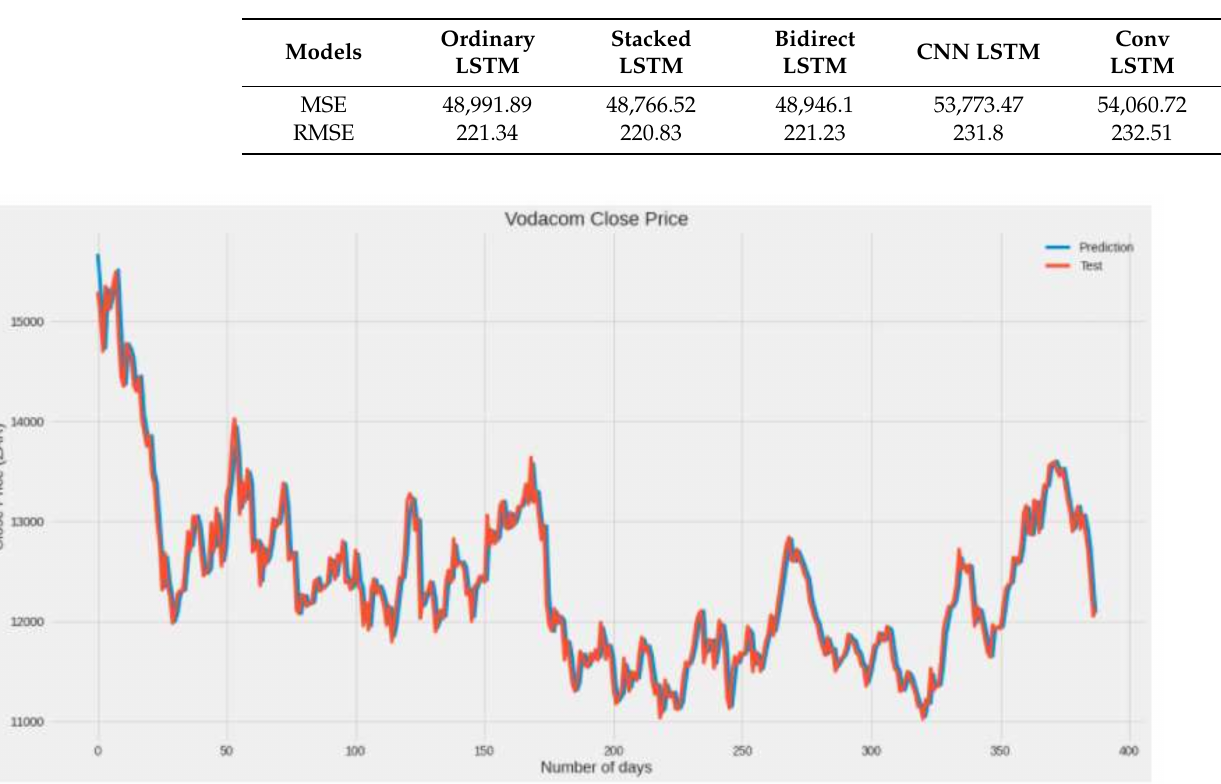
Table 4. Experiment 2.1 results.